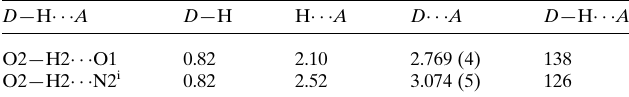
Table 1 Hydrogen-bond geometry (A˚ , (cid:3) ).